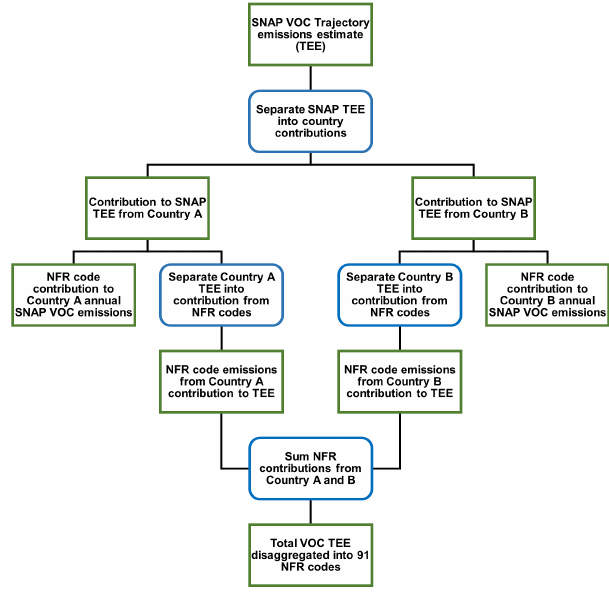
Figure 3. Flowchart representing the process used to derive the con- tribution from NFR codes to monthly TEE. The green rectangles represent products or data sets, and the blue rounded rectangles represent processes applied to transform a data set. Note that the separation of the TEE into contributions from two countries is illus- trative, and in most cases a greater number of countries contributed to the TEE in a given month. Further explanation is provided in Sect.